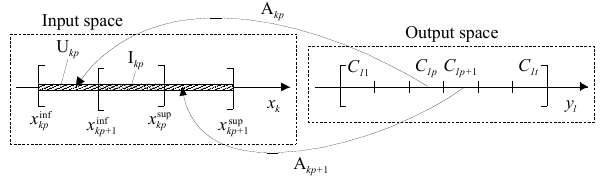
| and |U | are the lengths of the kp kp and A (input space), kp kp+1 and C (output space). lp lp+1